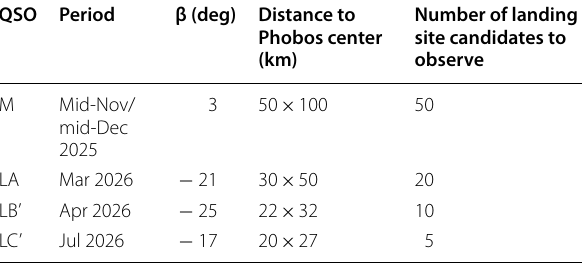
Table 3 Different orbits for landing sites selection